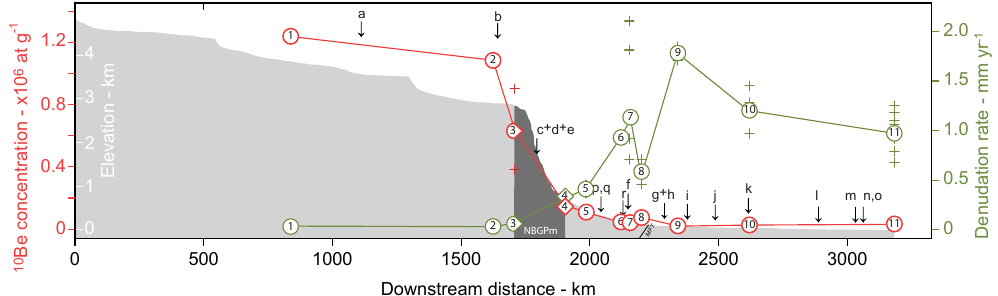
Figure 3. Downstream evolution of the 10 Be concentration (red) and corresponding denudation rates (green) of samples from the Tsangpo- Brahmaputra trunk stream. The elevation profile of the trunk stream channel is plotted in shaded grey. Arrows that point down refer to the confluences with the main Tsangpo-Brahmaputra tributaries. Open symbols are based on the average 10 Be concentration of all samples when multiple samples have been analyzed and crosses represent individual measurements. Open circles are from this study and open diamonds are samples from Finnegan et al. (2008).